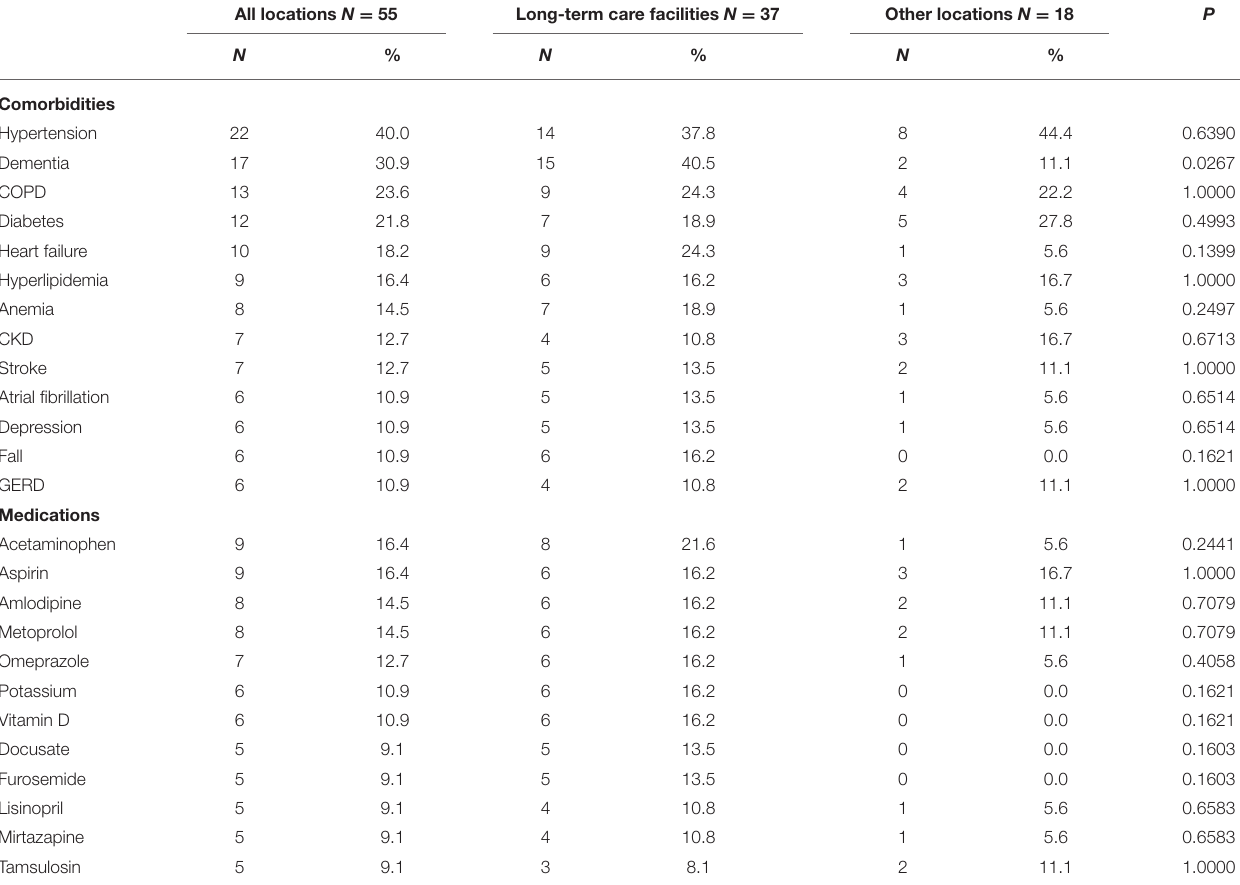
TABLE 2 | Top reported comorbidities and medications associated with deaths following COVID-19 vaccination by the location of vaccination. All locations N =